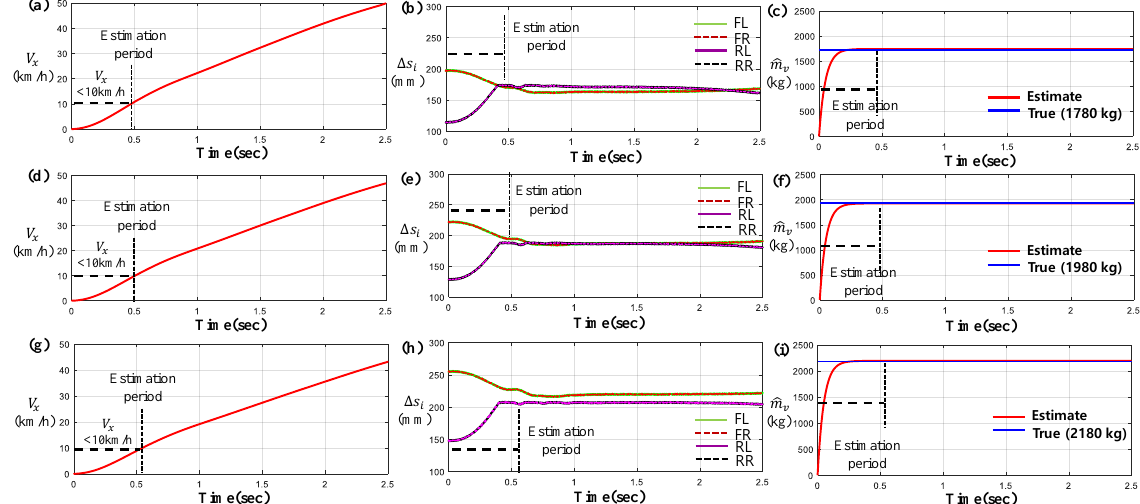
Figure 12. Mass estimation results. ( a ) Longitudinal velocity (1780 kg), ( b ) suspension deflections (1780 kg), ( c ) mass estimation (1780 kg), ( d ) longitudinal velocity (1980 kg), ( e ) suspension deflections (1980 kg), ( f ) mass estimation (1980 kg), ( g ) longitudinal velocity (2180 kg), ( h ) suspension deflections (2180 kg), and ( i ) mass estimation (2180 kg).